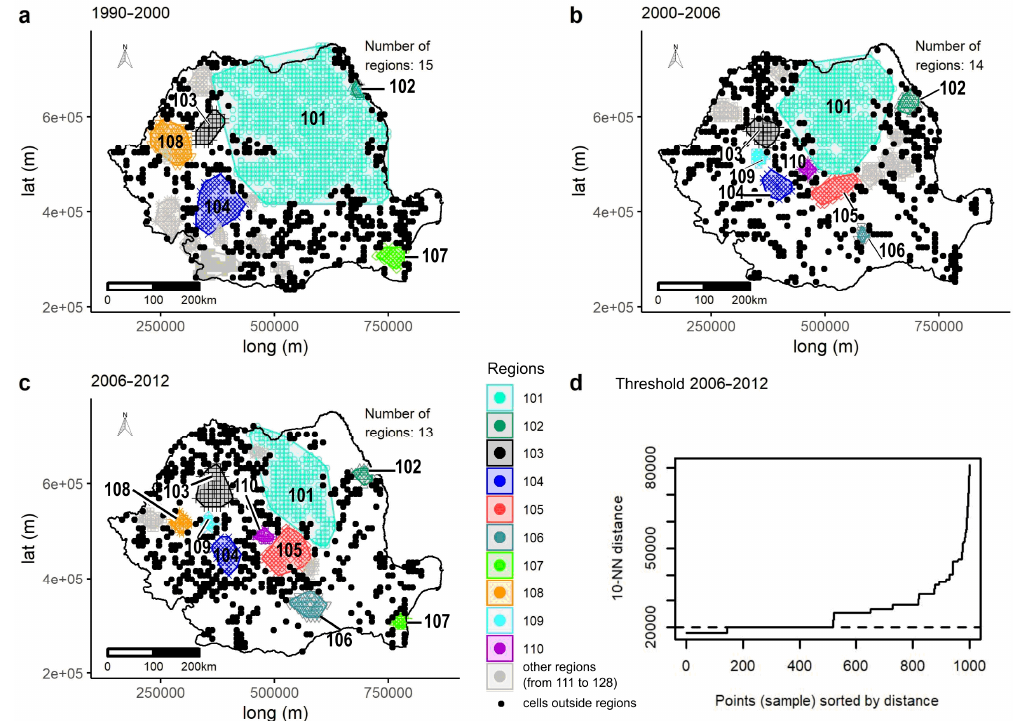
Figure 1. Cluster regions of land use changes by three study periods: ( a ) Period 1990–2006; ( b ) Period 2000–2006; ( c ) Period 2006–2012; ( d ) Example of computing the distance threshold for the period 2006–2012. Note: regions shown in colors (numbers from 101 to 110) have a common core in at least two periods; regions shown in grey (numbers from 111 to 128) are characteristic to just one of the study periods.